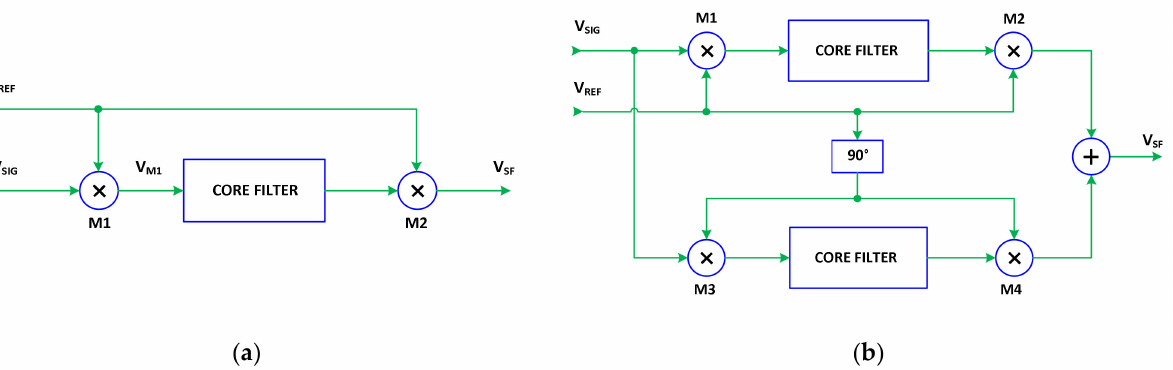
Figure 2. Diagram of the synchronous filtering concept: ( a ) in-phase SF, ( b ) out-of-phase SF design with a quadrature